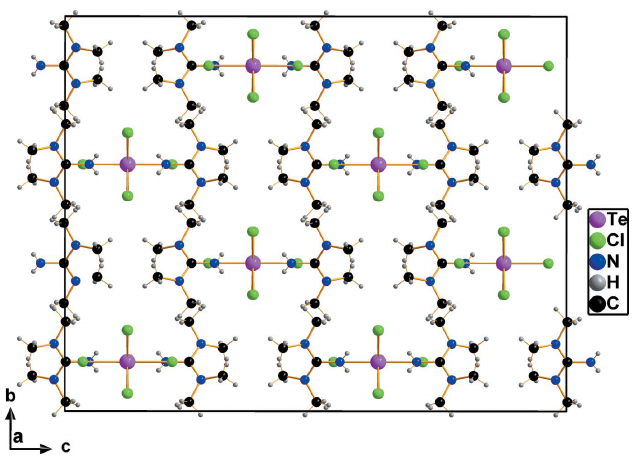
Figure 2 View along the a axis of the unit cell showing the arrangement of the ions of the title compound.